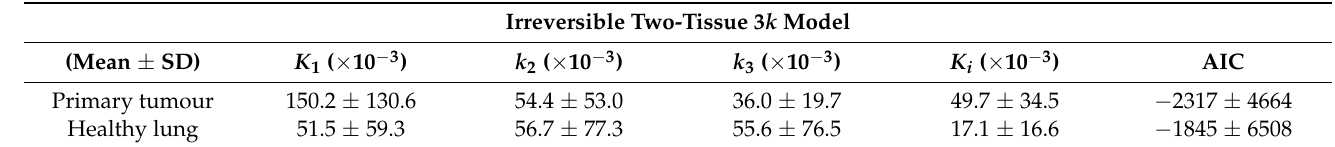
Table 2. The results of the compartmental analysis.